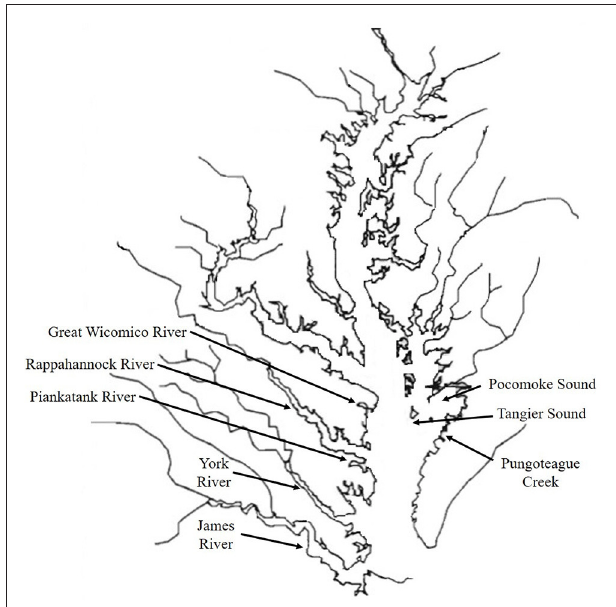
FIGURE 1 | Overview of Chesapeake Bay, key Virginia oyster fishery locations